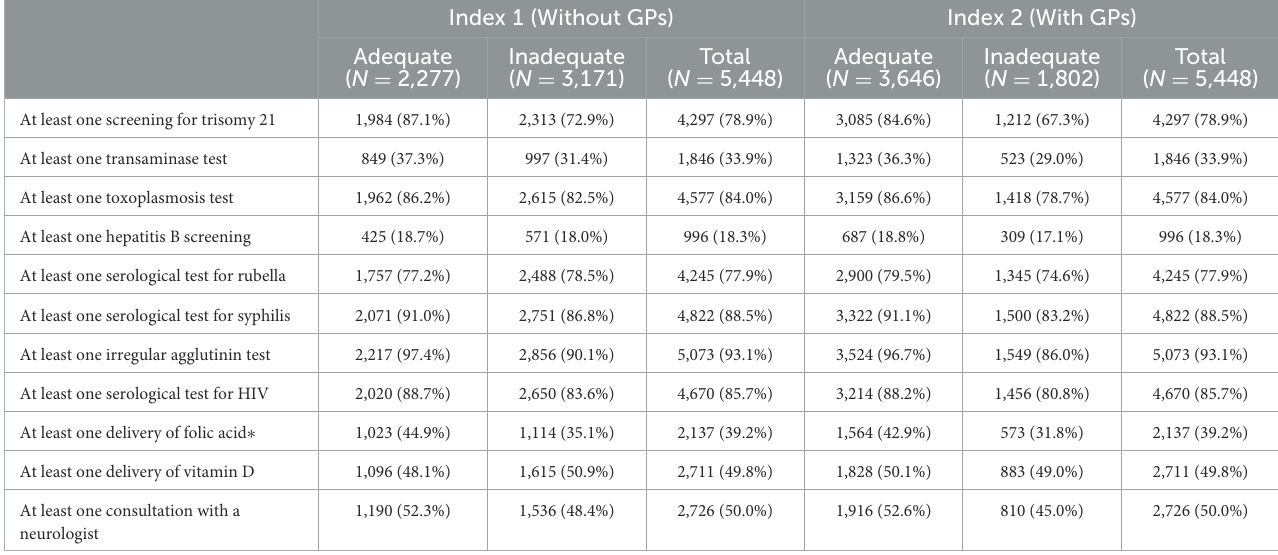
TABLE 4 Laboratory tests, vitamin supplementation, and neurological visits performed during pregnancy in the groups with adequate and inadequate prenatal